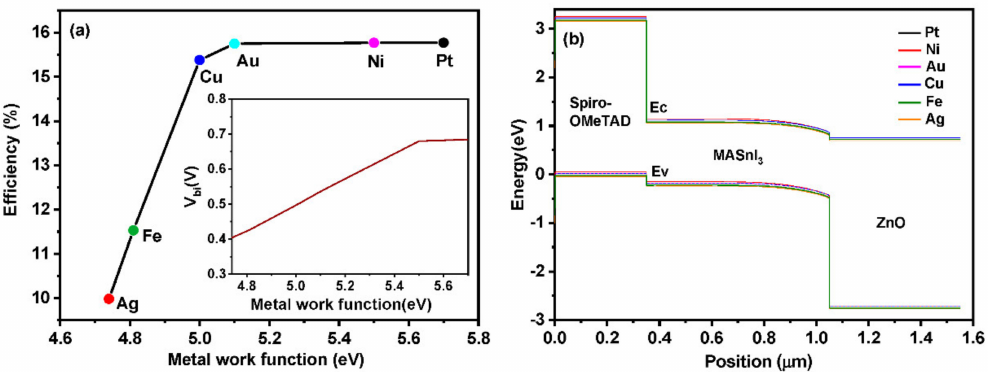
Figure 4. ( a ) Efficiency as a function of metal work function with varying back contacts and metal built in potential according to the metal contact (Inset). ( b ) Band diagram of constructed perovskite solar cell with different back contacts.